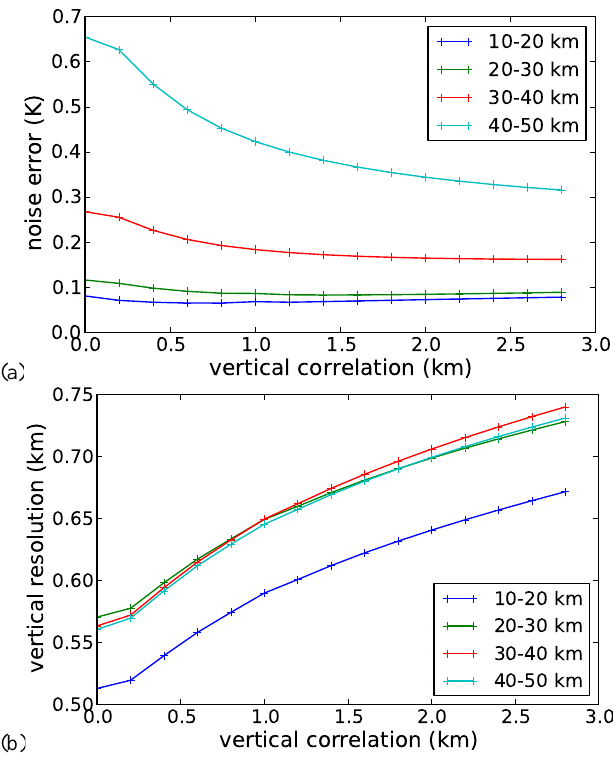
Fig. 11. The effect on vertical correlation length on vertical resolu- tion and noise error. The average resolution and retrieval noise for the four major height ranges are depicted. One can clearly see the tradeoff between vertical resolution and retrieval